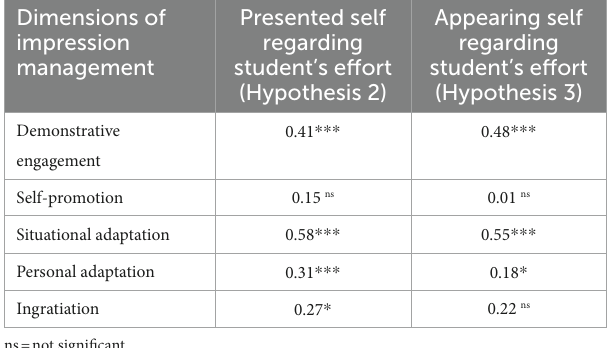
TABLE 4 Correlations between impression management and the presented as well as appearing self. Dimensions of